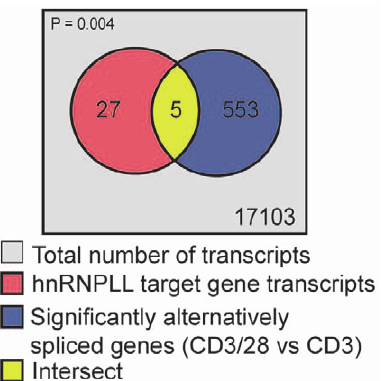
Figure 6. CD28 costimulation upregulates hnRNPLL mRNA expression in CD4 T cells. Sorted naı¨ve CD4 + CD25- T cells from wild type C57BL/6 mice were stimulated with bead-bound anti-CD3 alone or anti-CD3 plus anti-CD28 for the indicated times. Levels of mRNA were measured by real-time PCR. The relative expression is shown as the mean and SD of the fold induction above unstimulated T cells from three independent experiments. *indicates , 0.05 in Student’s t test.